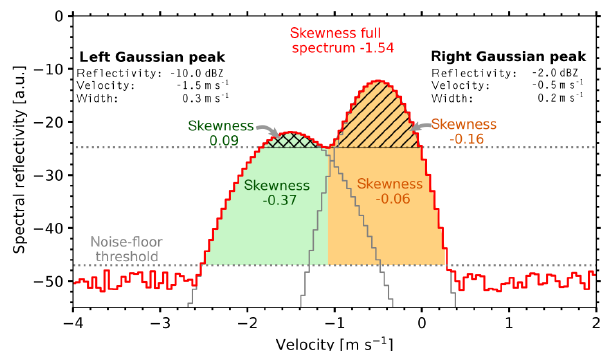
Figure A1. Example for different skewness values if the spectrum is cut at the local minimum or